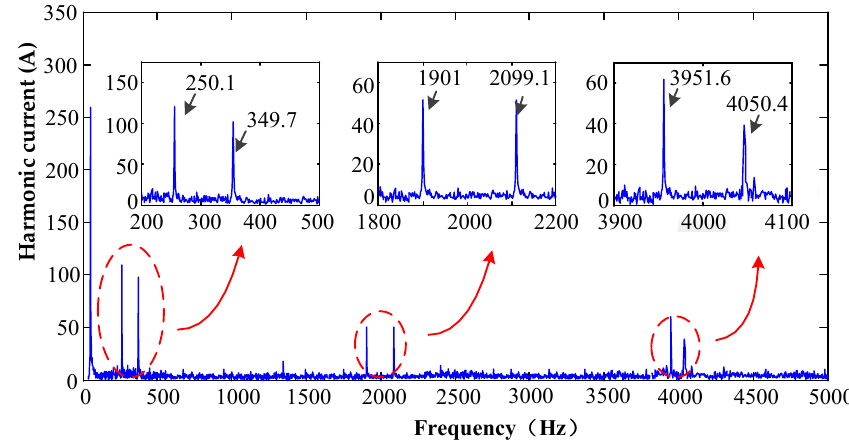
Figure 21. The FFT analysis of the simulated grid currents in the unstable.